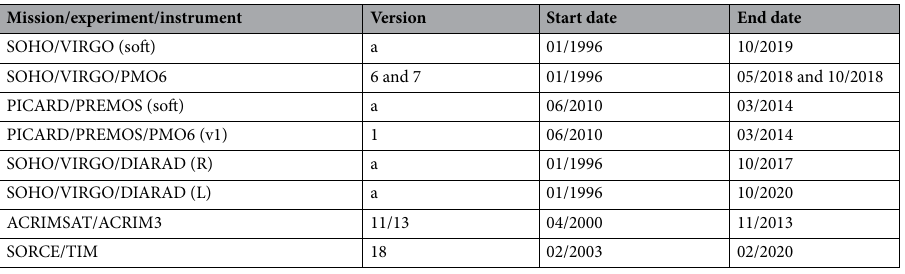
Table 1. Overview of the data sets used in this study. Note that soft is the data analysed with our software, PMO6 is the TSI time series released by PMOD, the DIARAD data set are provided by the Royal Meteorological Institute of Belgium 12 , whereas SORCE/TIM time series are downloaded from The University of Colorado Boulder 17 and ACRIM from http:// www. acrim. com. Note that DIARAD-R does not have any observations after 10/2017, whereas we use in this study DIARAD-L observations until